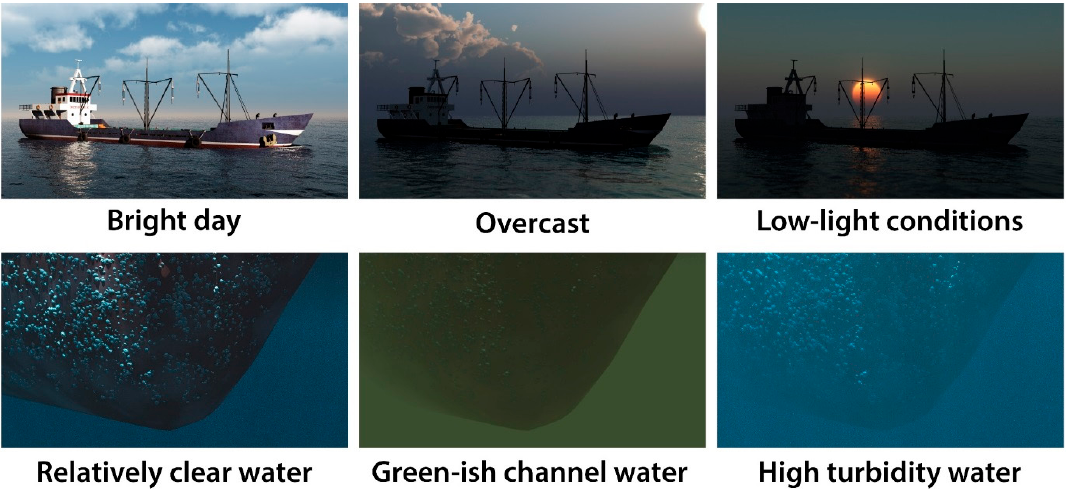
Figure 6. Training images of barnacle fouling of ship hull under varied underwater visibility conditions.